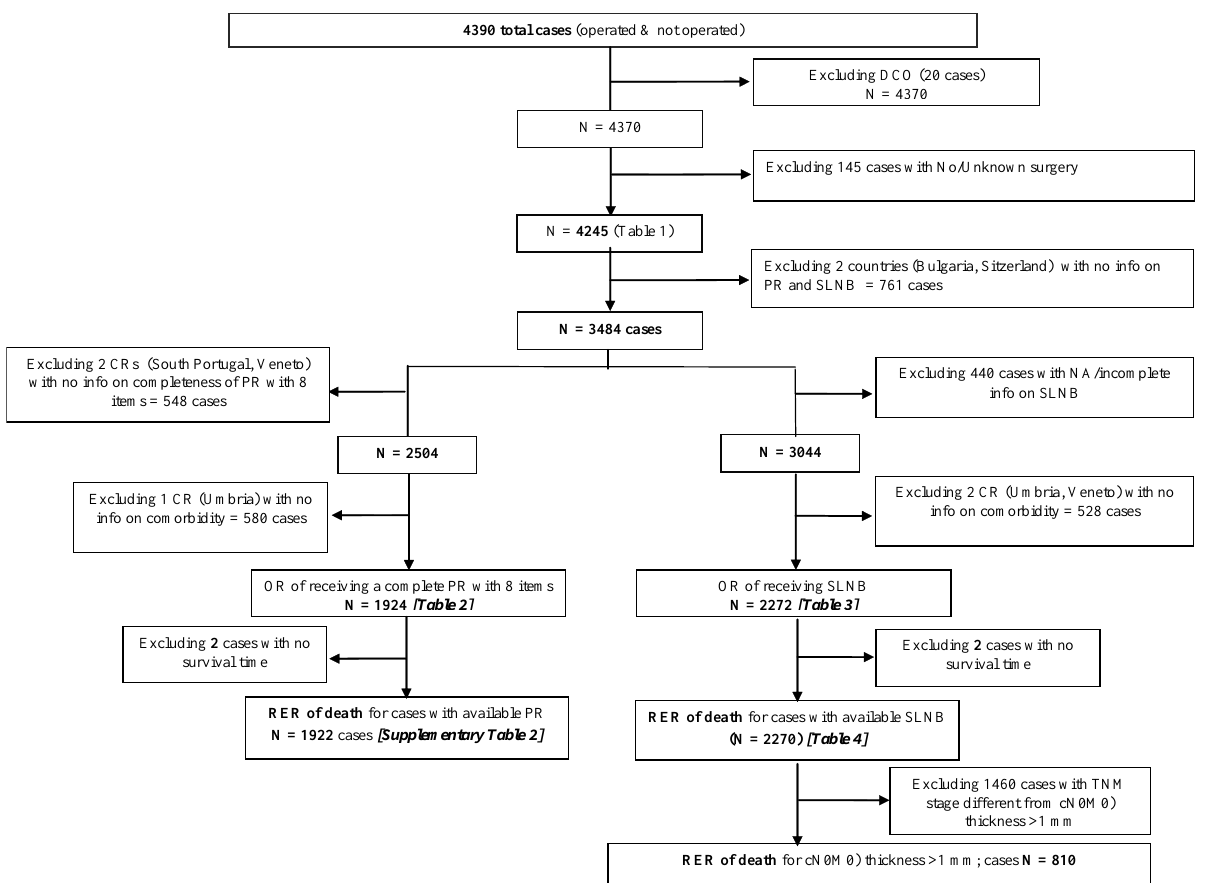
Figure 1. Process of identifying eligible cases for the analyses.